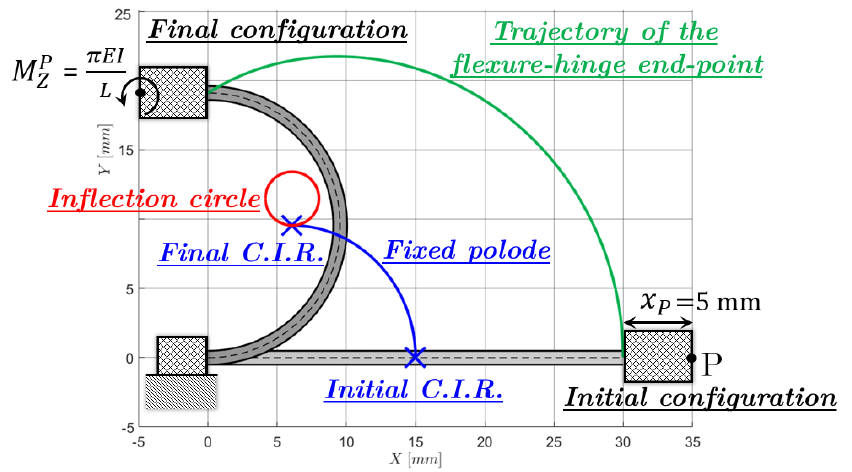
Figure 6. Flexure hinge loaded by a concentrated moment applied to the mobile rigid body.